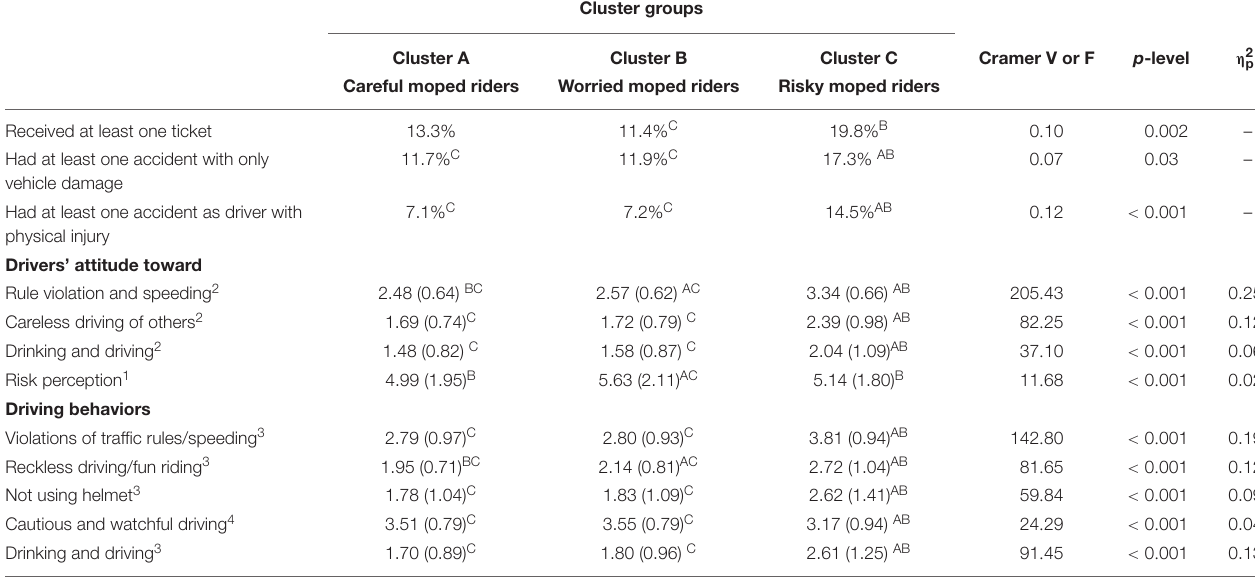
TABLE 4 | Cluster differences on the raw scores of driving outcome